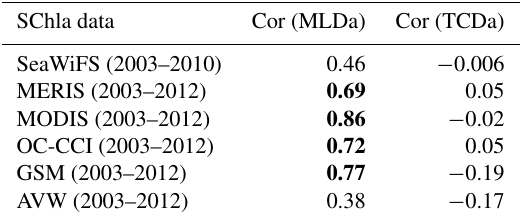
Table 2. Correlation between average interannual NAS box winter (DJFM) SChl anomalies derived from satellite products and inter- annual in situ MLD and TCD anomalies. Bold typeface indicates correlations which are statistically different from zero at the 90% confidence